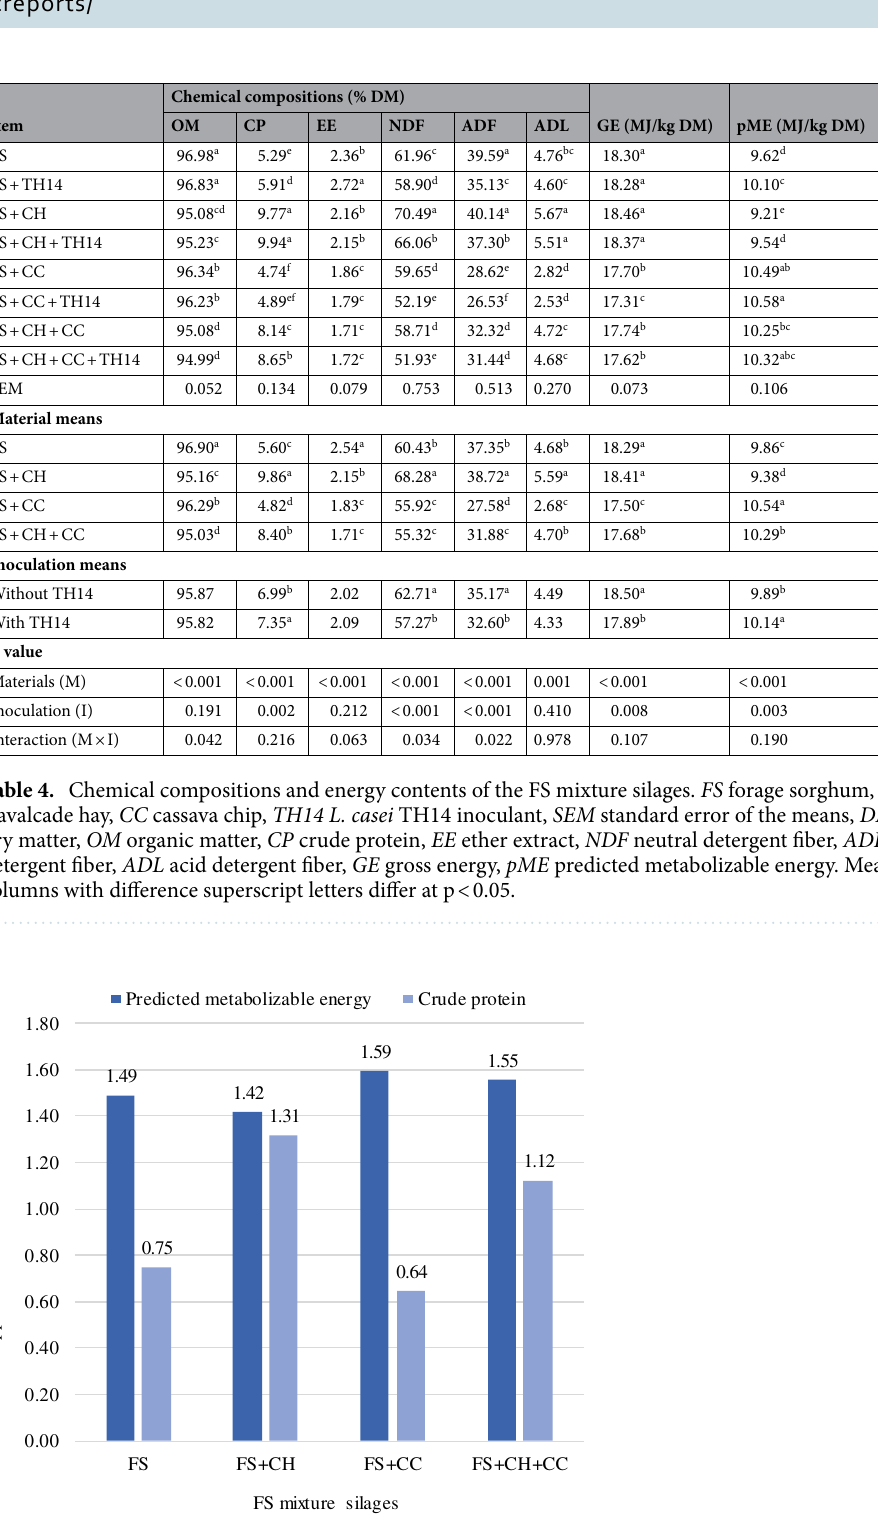
Figure 1. The nutritive values of the tested forage sorghum (FS) mixture silages estimated to supply the maintenance requirements of Zebu beef cattle in the growth stage according to current feeding standards 3 . CH Cavalcade hay (15% inclusion rate), CC dry cassava chip (10% inclusion